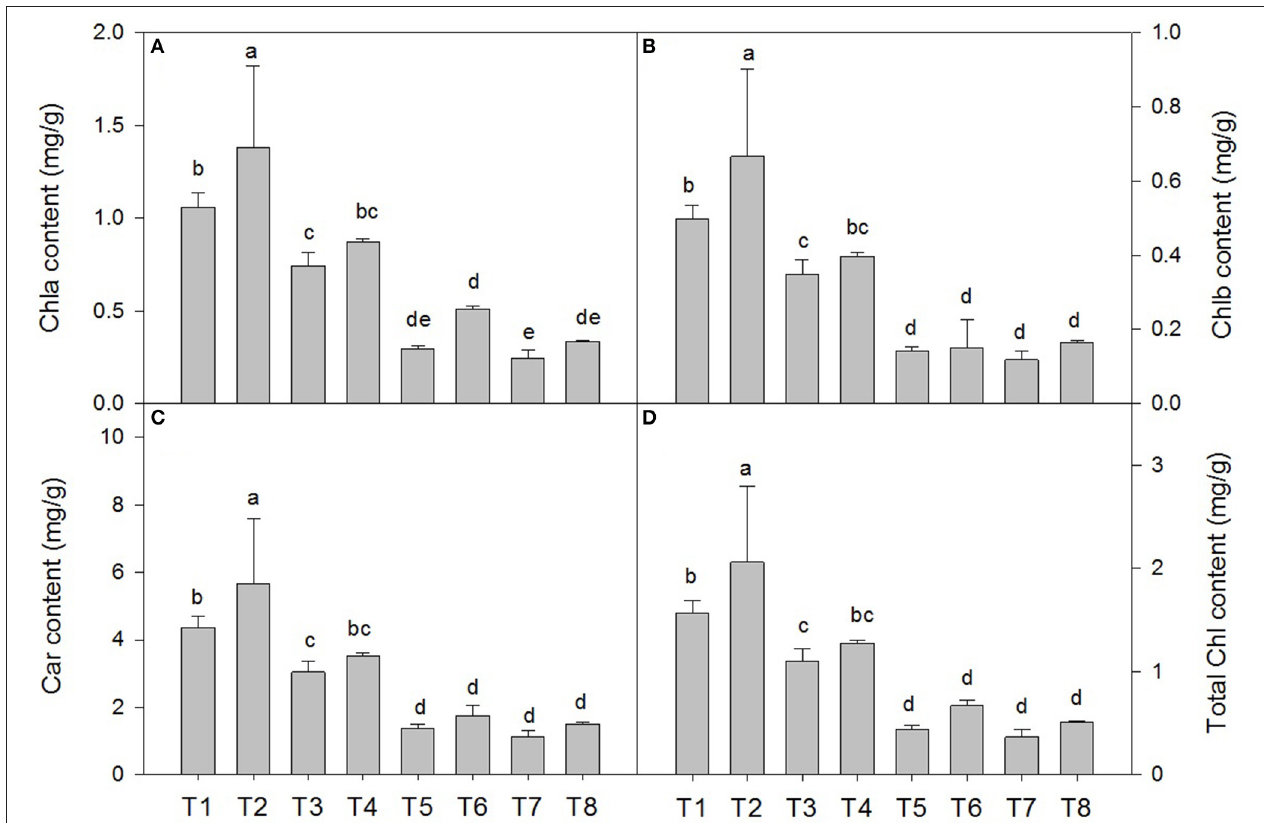
FIGURE 2 | Effects of SA on the chlorophyll a (chla) (A) , chlorophyll b (chlb) (B) , carotenoid (car) (C) and total chlorophyll content (D) in D. superbus grown under salt stress (means ± SD ). Different letters indicate significant differences ( P < 0.05) according to an LSD-test; the same letter indicates no significant differences between the treatments, n =